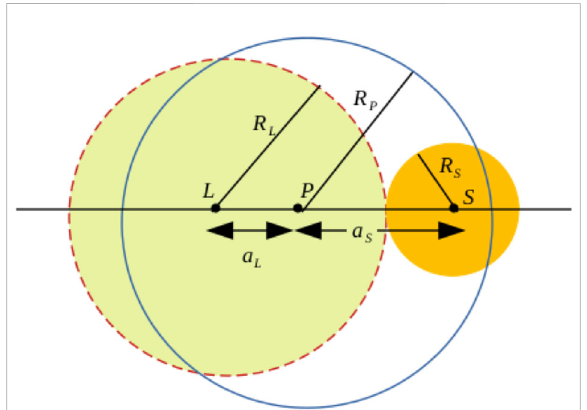
Schematic of two unequal-sized coalescing parent droplets withcentresatL(large)andS(small)andtheproductdropletwitha centre at P. The separation distances between the larger and smaller parents from the centre of the coalesced drop are marked as a L and a S , respectively. The radii of the droplets are denoted by R L (larger parent), R S (smaller parent), and R P